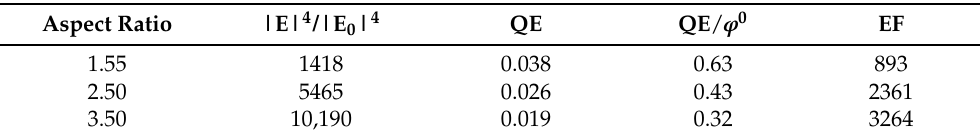
Table 1. Characteristics of the two-photon excitation fluorescence enhancement of eqFP670 placed at 3 nm to the corner of the Ag nanobar with various aspect